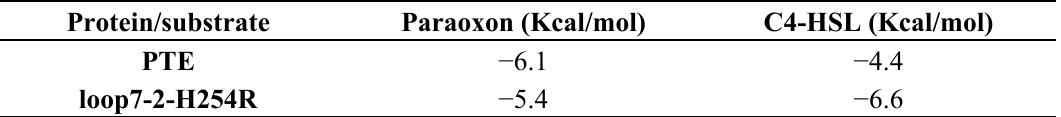
Table 3. The docking score calculated by Autodock